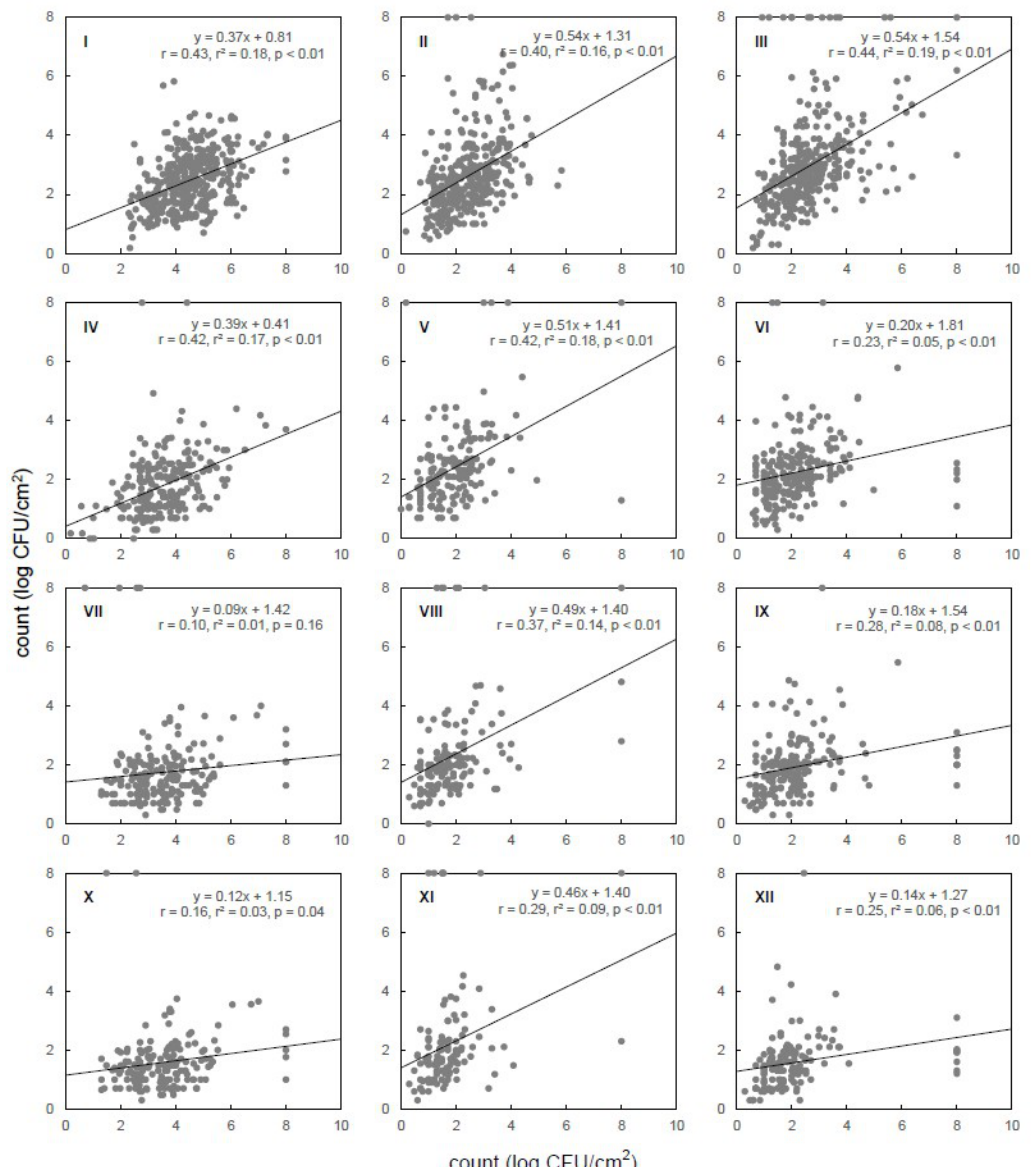
Figure 1. Dispersion of microbial counts (log CFU/cm 2 ) of mesophilic aerobes (I, II, III), Enterobacteriaceae (IV, V, VI), total coliforms (VII, VIII, IX), and Escherichia coli (X, XI, XII) from bovine carcasses obtained in different steps of slaughtering (‘y’ vs. ‘x’): ‘after hide removal (step 1)’